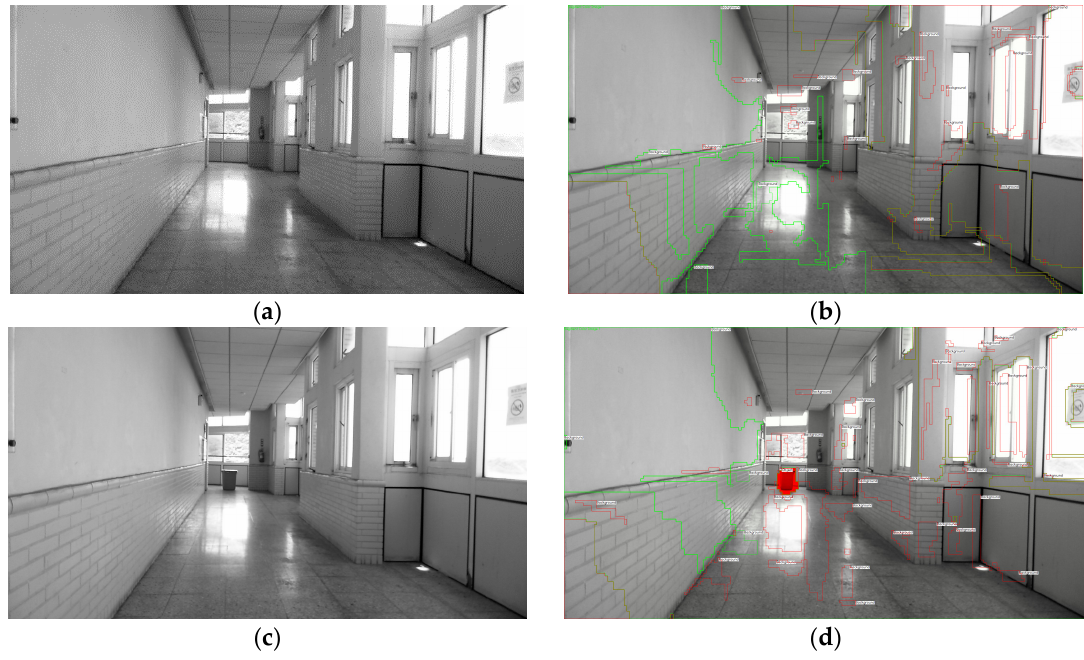
Figure 5. Classifications of the background environment and object: ( a ) background environment; ( b ) training background color distribution; ( c ) add object in background environment; ( d ) classifications of the background environment and object.